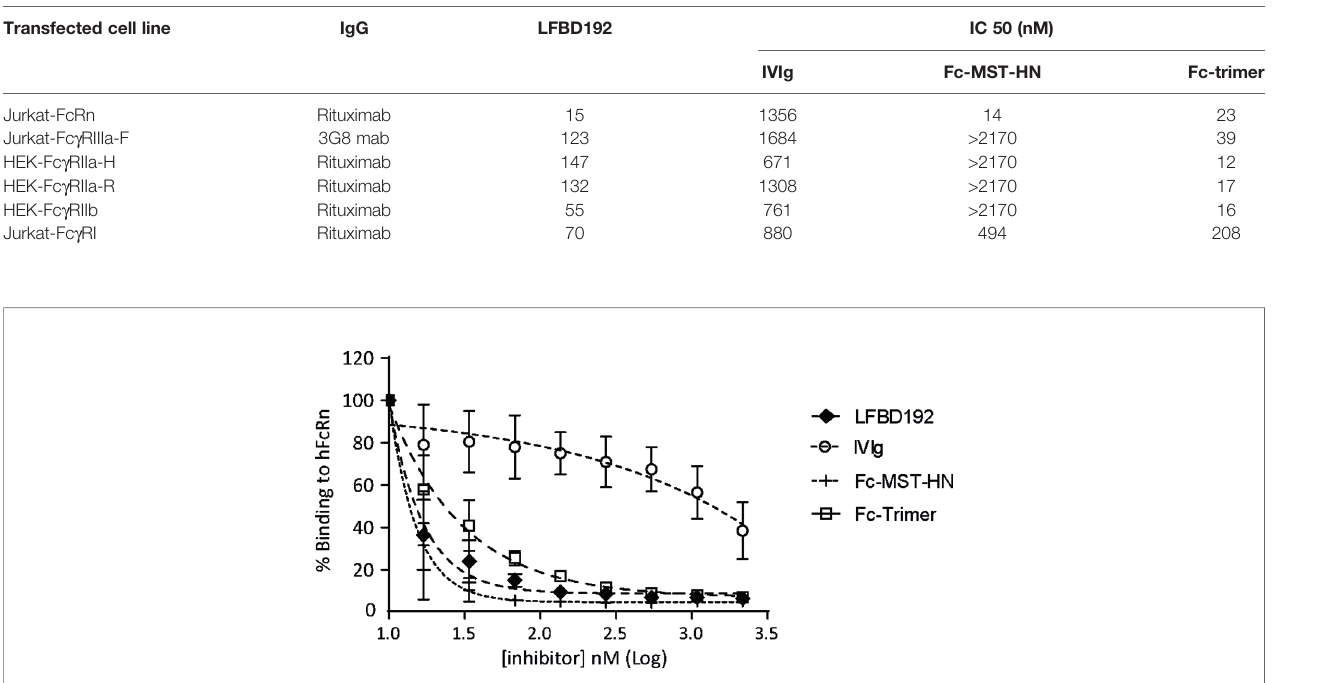
FIGURE 2 | LFBD192 blocks the binding of IgG to FcRn. The binding of LFBD192, IVIg, Fc-MST-HN, and the Fc-trimer to human FcRn expressed at the surface of Jurkat cells measured at pH 6.0 in a competitive assay in the presence of Alexa-labeled rituximab (30 µg/mL) (data represent the means ± SEM of two experiments, each experiment performed in triplicates).